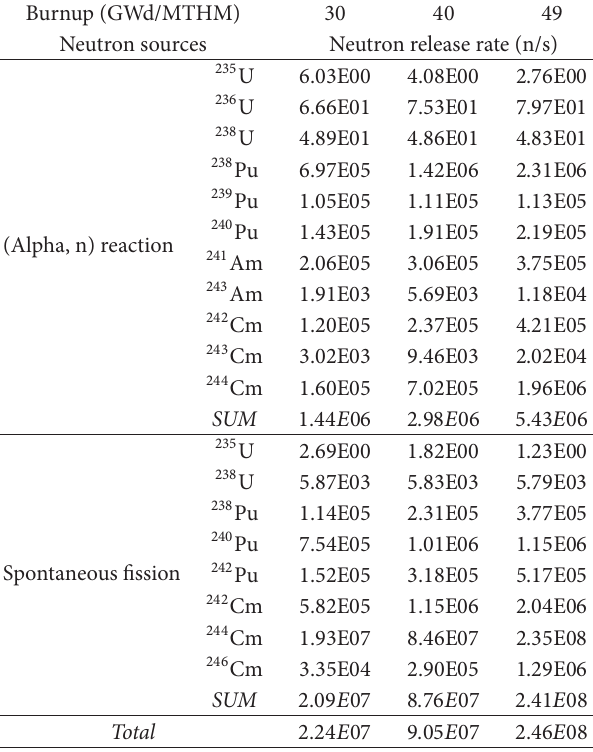
Table 4: Photon release rate of the BNPP SFA in 18 groups of energy (49GWd/MTHM and 3-year cooling time).